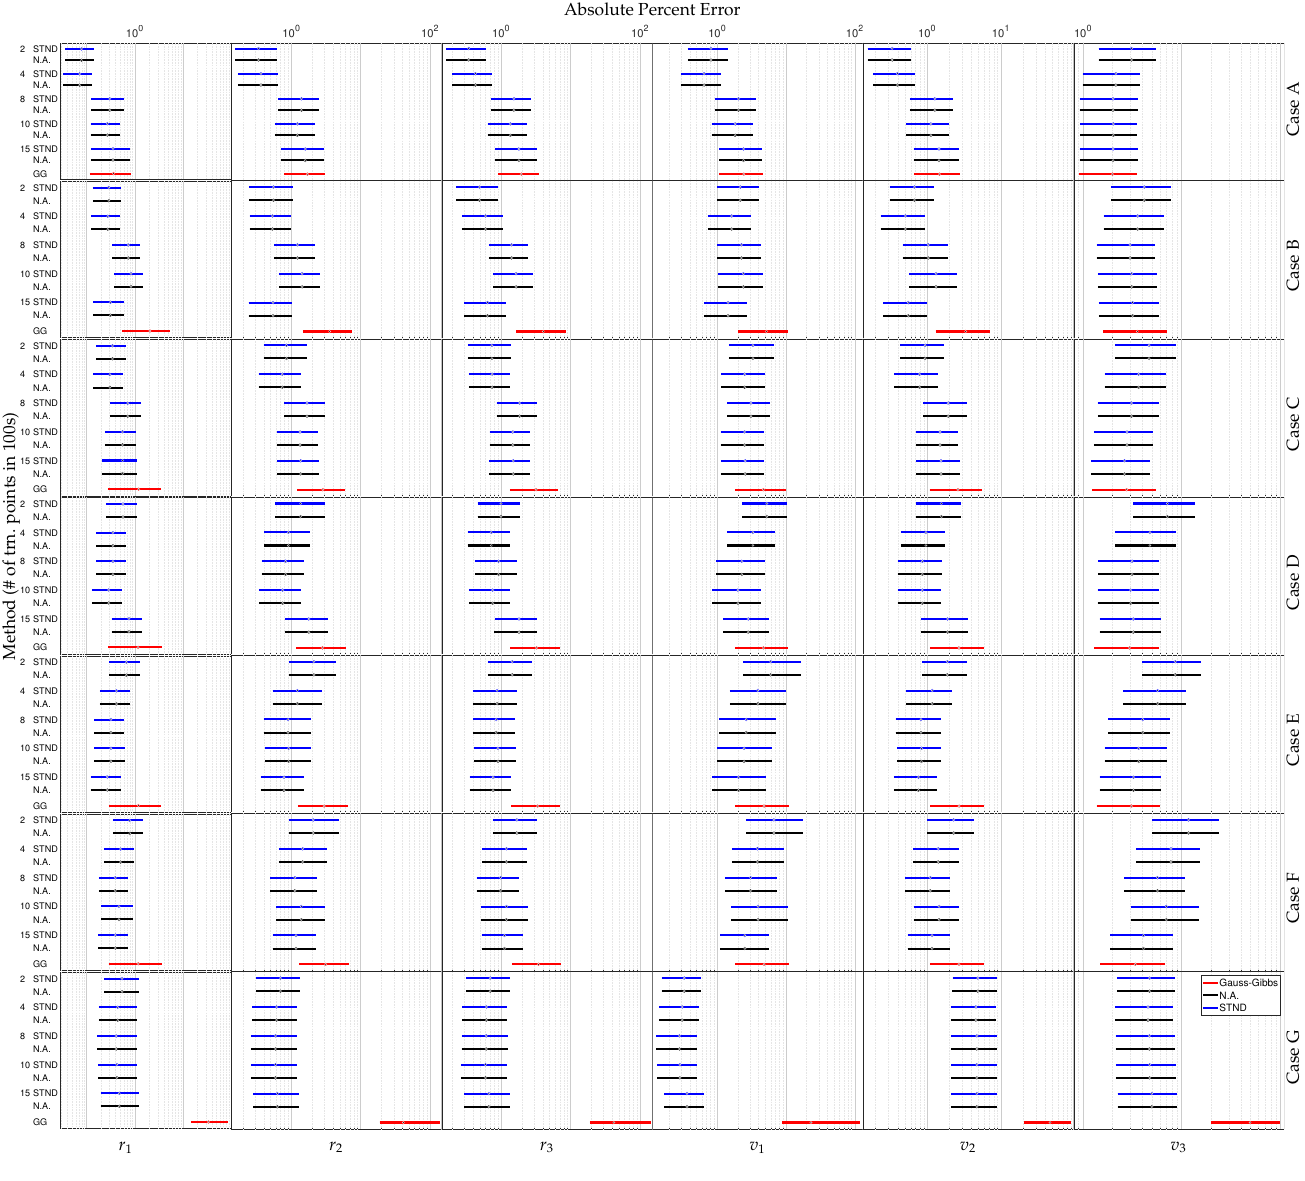
Figure 5. The point represents the median APE while the boxes enclose the range of points between the 25th and the 75th quantiles of APE for each Cartesian state given uncertain RA and DEC measurements. The GPR methods are listed STND. (blue) Then, N.A. (black) and are ordered by number of training points—200, 400, 800, 1000, and 1500—listed in 100s. The Gauss–Gibbs results are labeled GG and shown in (red). Table 4. Median APE for for most accurate model in each orbit case given noisy RA and DEC